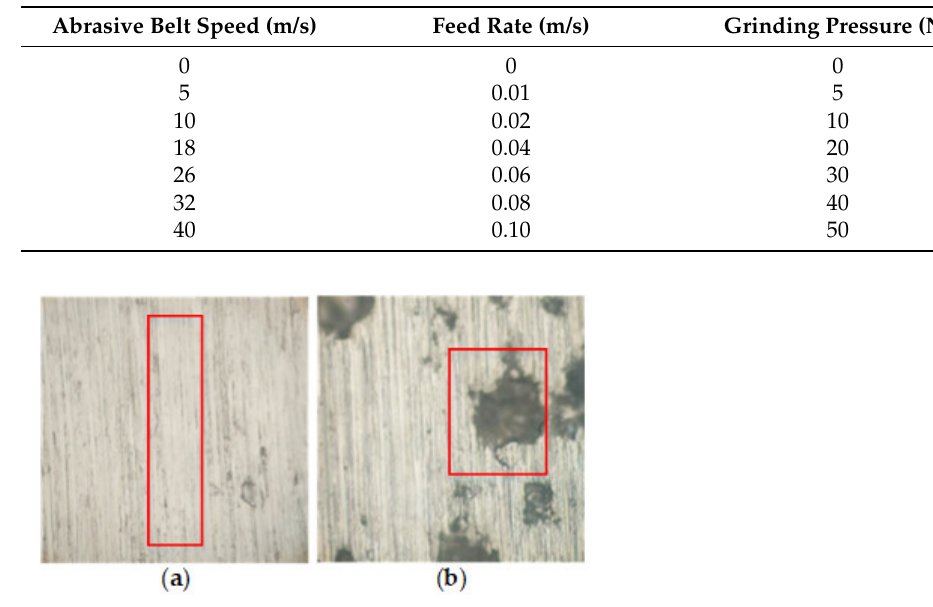
Figure 4. ( a ) Empty grinding; ( b ) apparent surface defects.